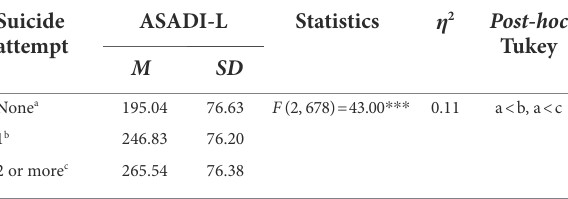
TABLE 5 Comparisons of the ASADI-L among people with no suicide attempt, single suicide attempt and multiple suicide attempt. Suicide